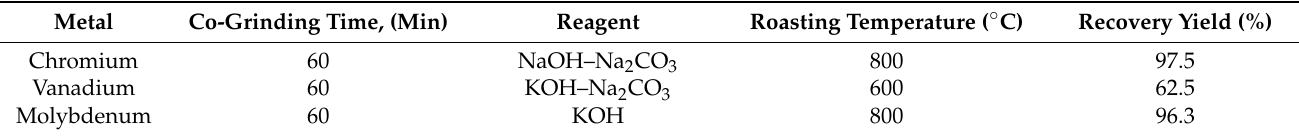
Table 5. Summary of the best conditions for the recovery of Cr, V, and Mo from EAF slag. Metal Co-Grinding Time, (Min) Reagent Roasting Temperature ( ◦ C) Recovery Yield (%) Chromium 60 NaOH–Na 2 CO 3 800 97.5 Vanadium 60 KOH–Na 2 CO 3 600 62.5 Molybdenum 60 KOH